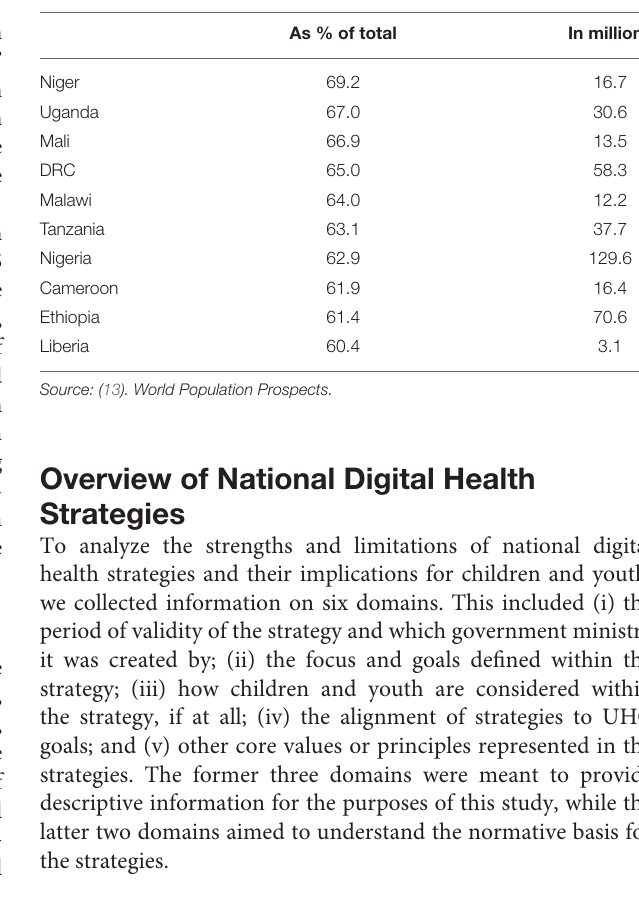
TABLE 1 | Population under 25 years by